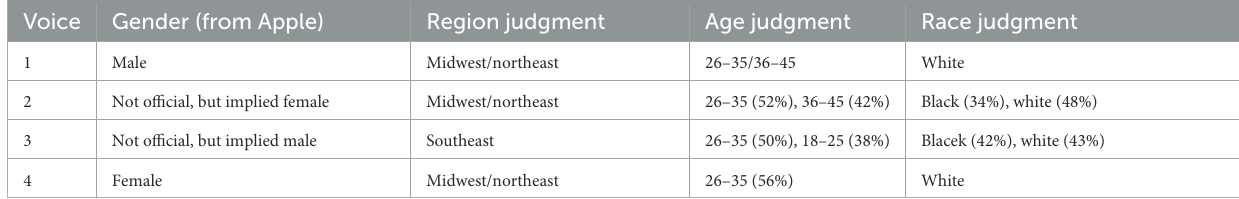
TABLE 1 Most frequent listeners ratings by gender/region/age/race for each Siri voice.